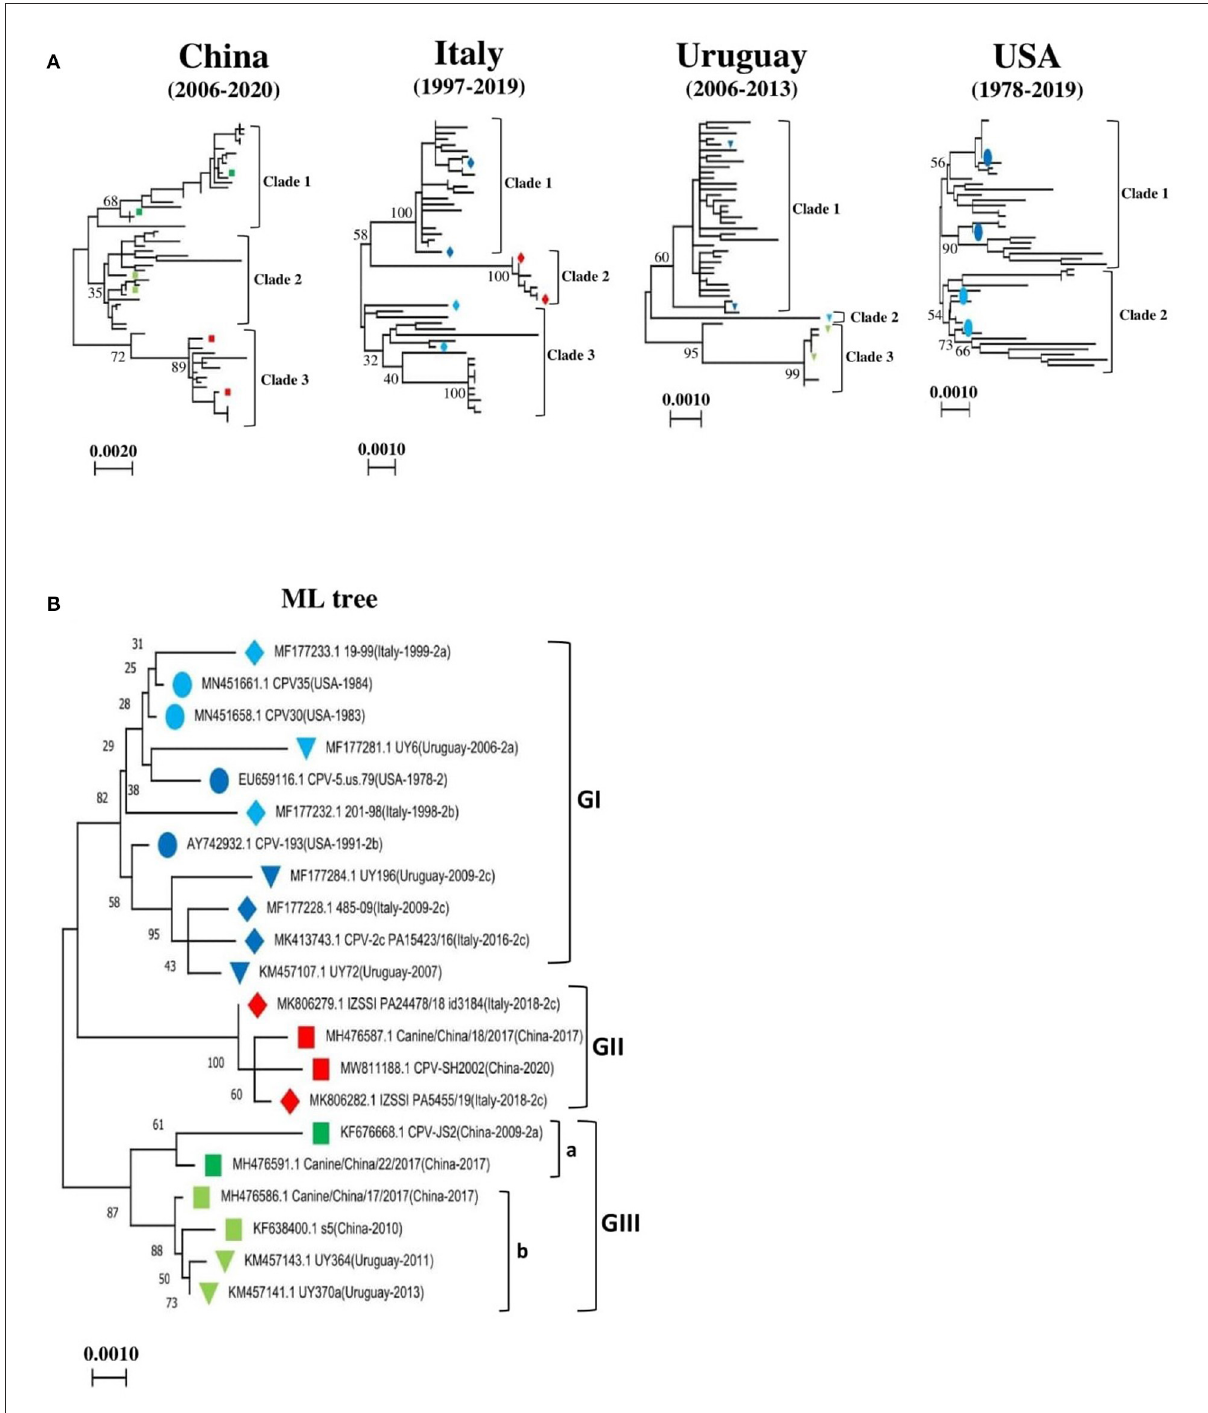
FIGURE1 Country-based phylogenetic trees of the entire genome sequences of CPV-2 strains. (A) Maximum-Likelihood (ML)-based trees of CPV-2 strains from four main countries: China ( n = 62), Italy ( n = 50), the USA ( n = 47), and Uruguay ( n = 48). Trees were generated using MEGA 11 software. Three main clades in phylogenetic trees of China, Italy and Uruguay are shown (clade1, 2 and 3), and two main clades (clades 1 and 2) in the USA. (B) Consensus phylogenetic tree of twenty-one standard reference sequences of CPV-2 strains. The standard references correspond to representative CPV-2 strains from each phylogenetic tree clade of (A) . The numbers at each branch indicate the percentage of bootstrap values of 1,000 replicates. The scale bars reveal the number of inferred substitutions per site. The CPV-2 strains are identified in a format as